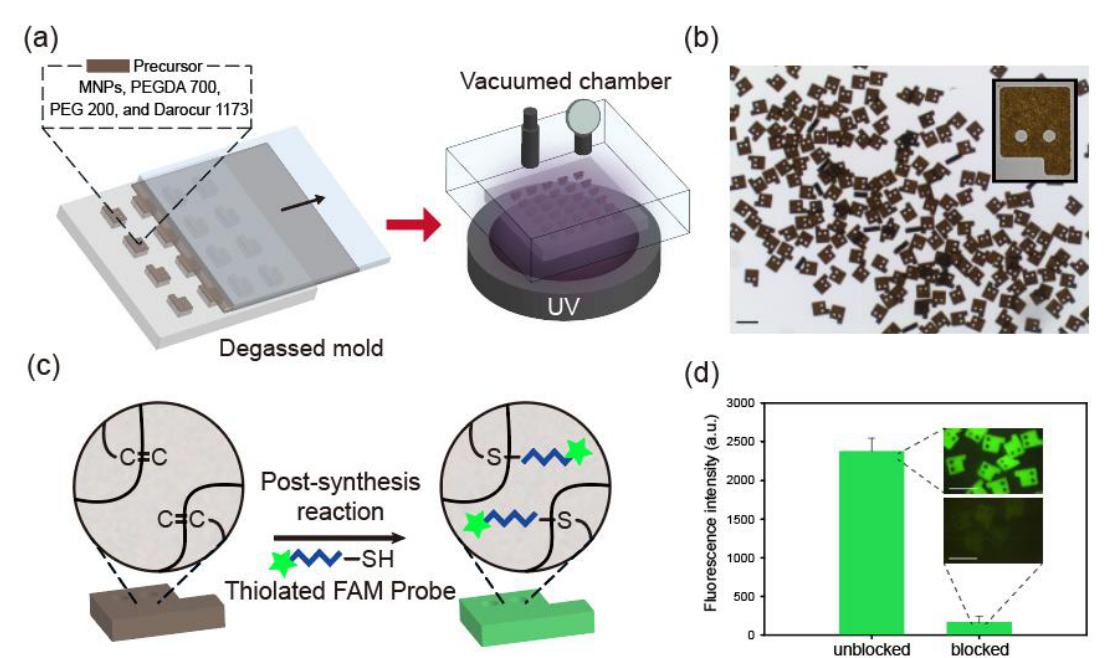
Figure 1. Overview of magnetic hydrogel microparticle synthesis and post-synthesis probe conjugation. ( a ) Scheme of discontinuous dewetting on a degassed PDMS mold. UV light is exposed in a vacuum chamber to offset the oxygen inhibition effect. ( b ) Bright-field images of synthesized magnetic microparticles. ( c ) Conjugation of thiolated FAM probes to magnetic microparticles via post-synthesis conjugation. ( d ) Fluorescence intensities of microparticles depending on blocking treatment for unreacted double bonds. Scale bars are 100 μm.